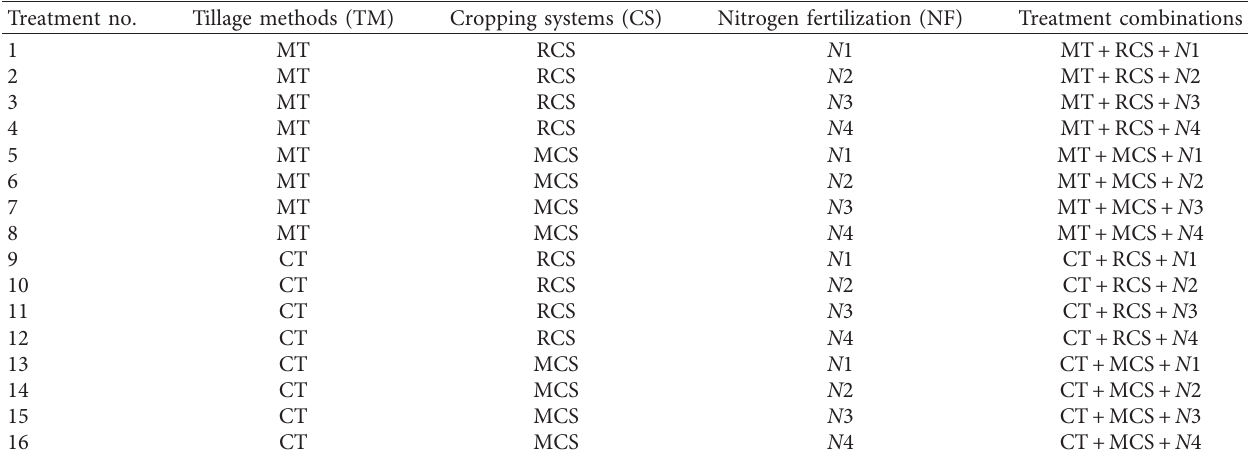
Table 2: Arrangement of experimental treatments.